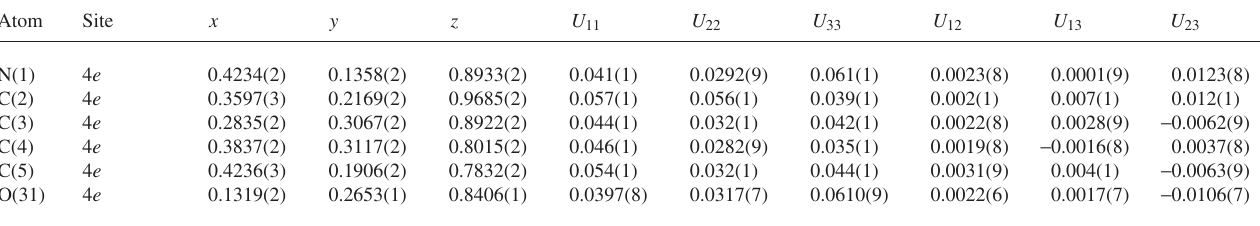
Table 3. Atomic coordinates and displacement parameters (in Å 2 )